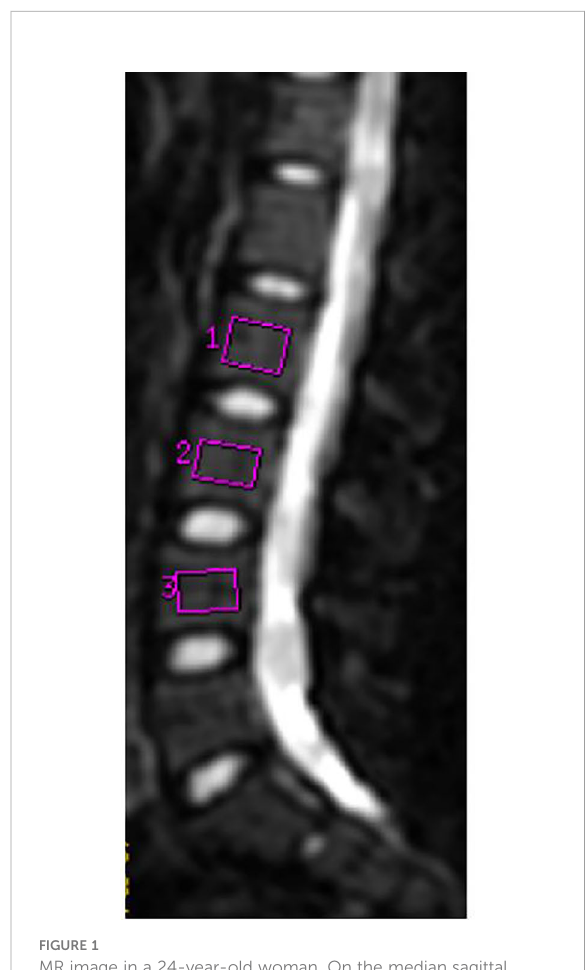
FIGURE 1 MR image in a 24-year-old woman. On the median sagittal image with b = 0, L2 – L4 vertebrae were selected to delineate